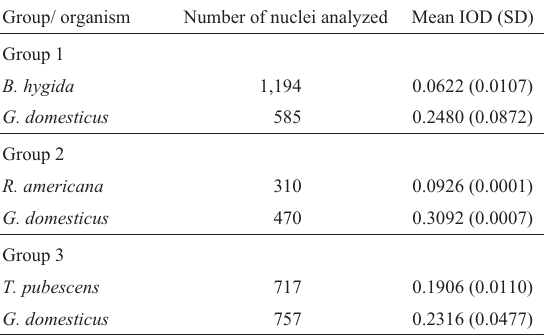
Table1 -MeanFeulgen-DNAintegratedopticaldensity(IOD)valuesand standard deviation (SD) for Bradysia hygida , Rhynchosciara americana , Trichosia pubescens and Gallus domesticus .